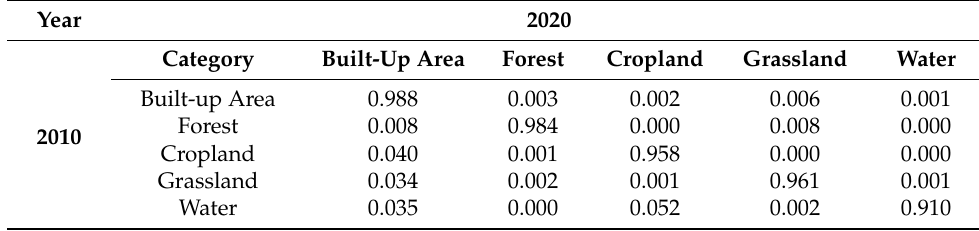
Table 9. Transition Matrix from 2010–2020.